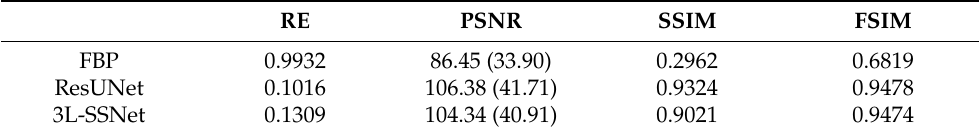
Table 2. The average of the full-reference metrics on the test set in the case of full-range geometry. RE PSNR SSIM FSIM FBP 0.9966 86.42 (33.89) 0.2924 0.5456 ResUNet 0.0942 106.99 (41.95)